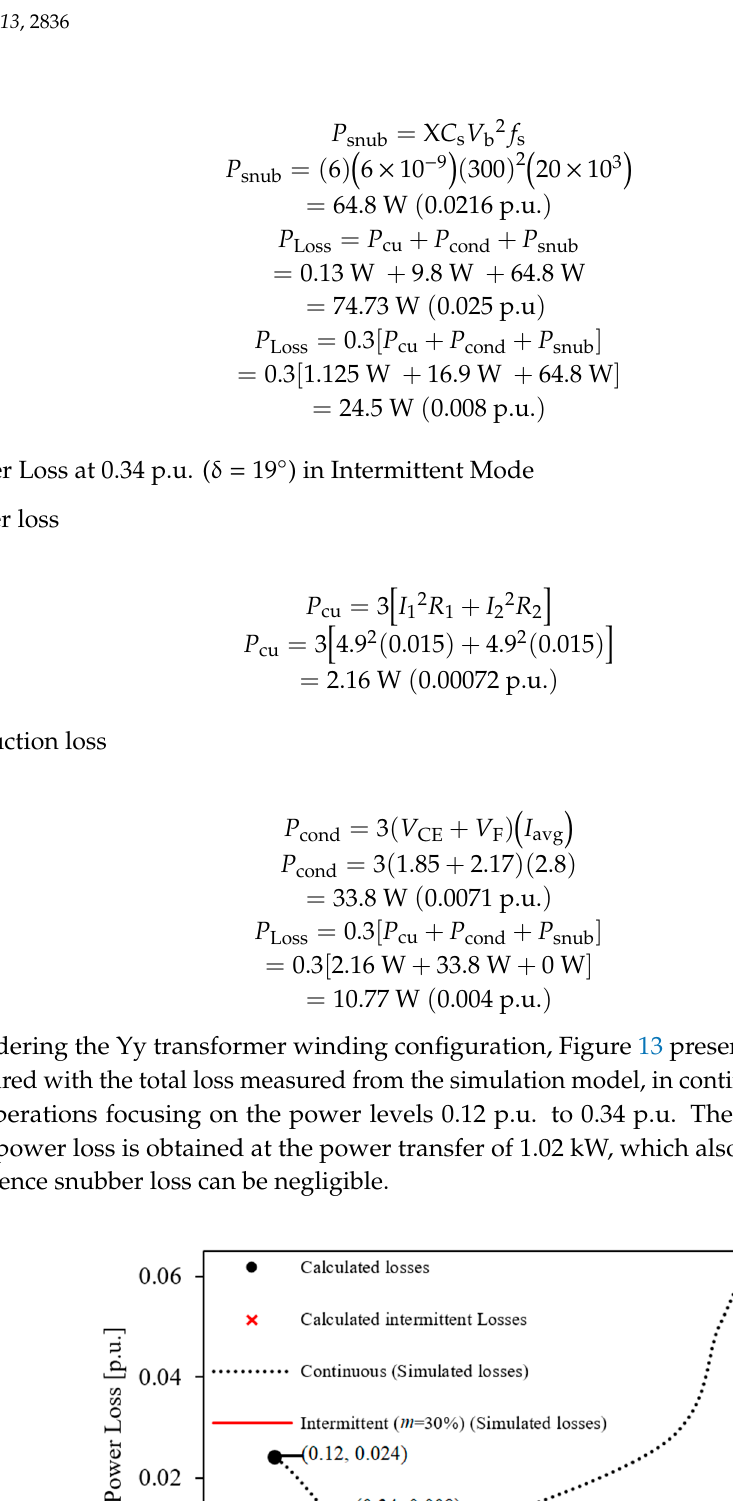
( a ) ( b ) Figure 14. Power loss distribution of the 3P-BIDC in continuous operation; snubber, copper, and conduction losses at ( a ) 0.12 p.u. ( b ) 0.34 p.u.